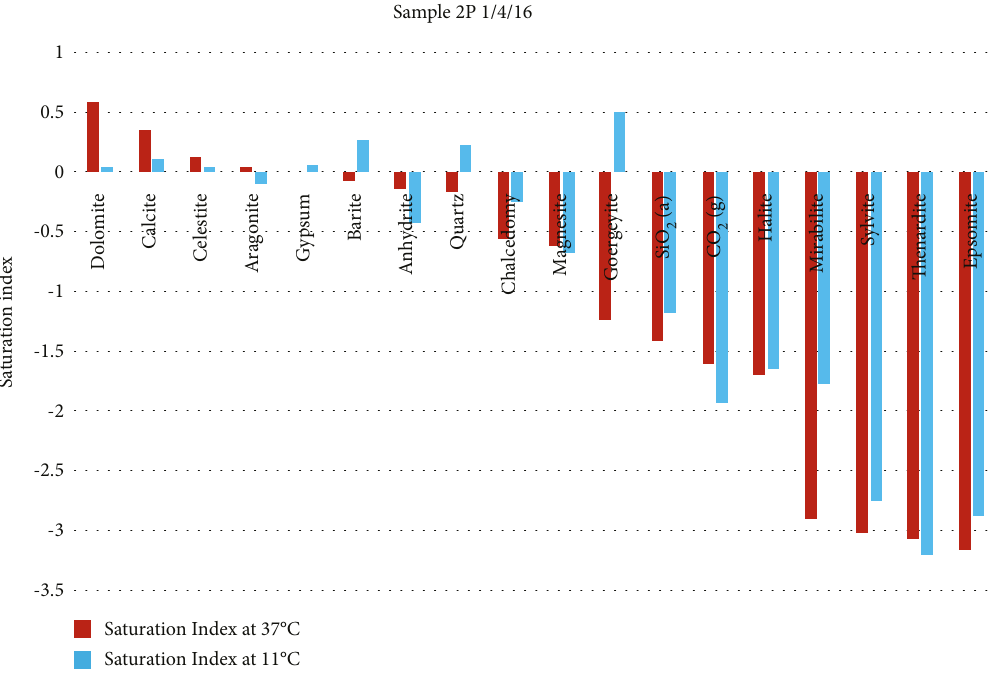
Figure 6: Diagram illustrating the relative saturation indices of various minerals at 37 ° C and 11 ° C for the Klaipeda 2P water sample of 1st April 2016 (from Table 4). Table 6: Calculated potential loss of gypsum and barite per